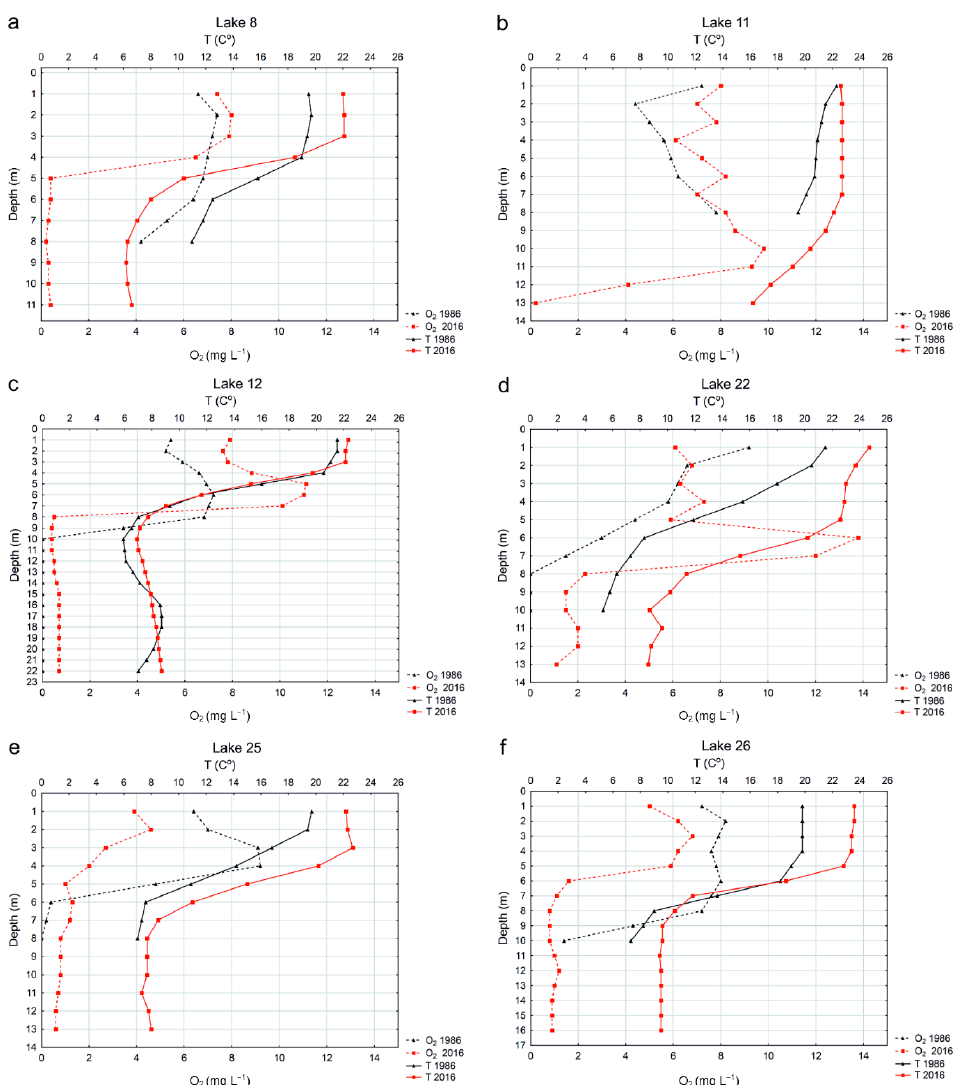
Figure 4. The comparison of thermal and oxygen vertical profiles performed for selected lakes during summer stagnation in 1986 and 2016. Explanations: ( a )—Lake No. 8, ( b )—Lake No. 11, ( c )—Lake No. 12, ( d )—Lake No. 22, ( e )—Lake No. 25, ( f )—Lake No. 26.